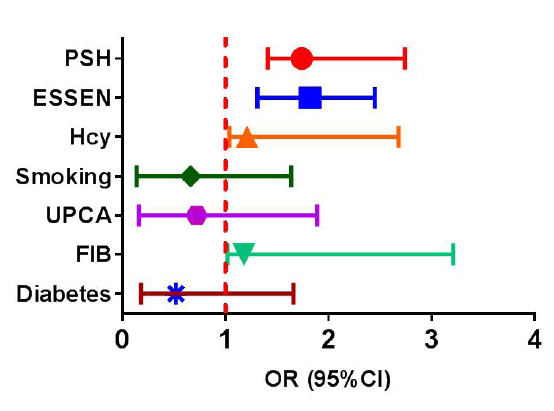
Figure 1: Forest plot for independent risk factors for